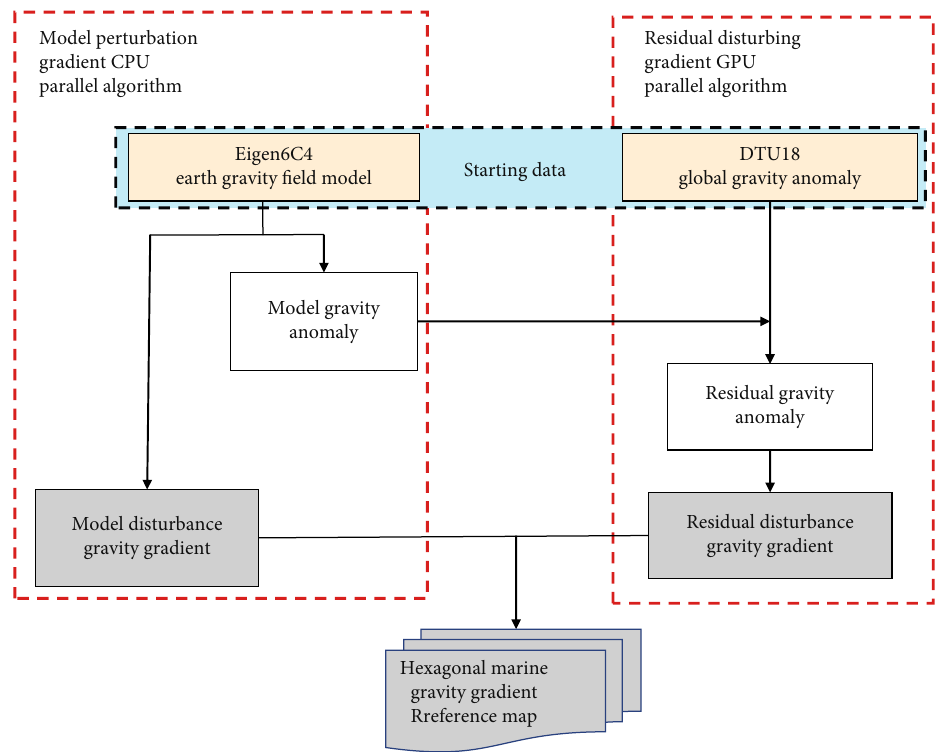
Figure 6: Reference map ’ s construction fl